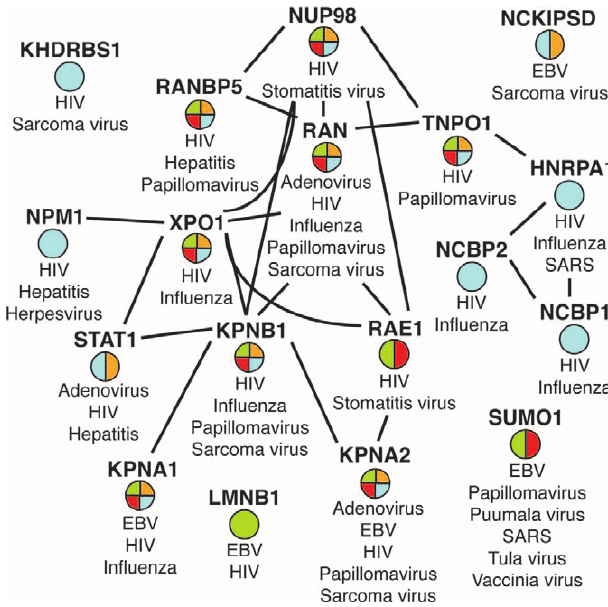
Figure 5. Human Nuclear Membrane Proteins Interacting with Multiple Viral Pathogen Groups Enriched network of human proteins annotated with ‘‘ nuclear transport ’’ (blue), ‘‘ nuclear membrane part ’’ (green), ‘‘ protein import ’’ (orange), and ‘‘ nuclear pore ’’ (red). An edge connecting two proteins denotes a known interaction in the human PPI network.